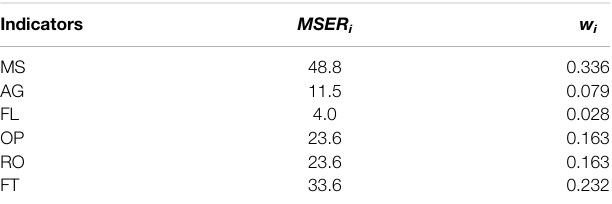
TABLE 8 | Importance and weights of vulnerability